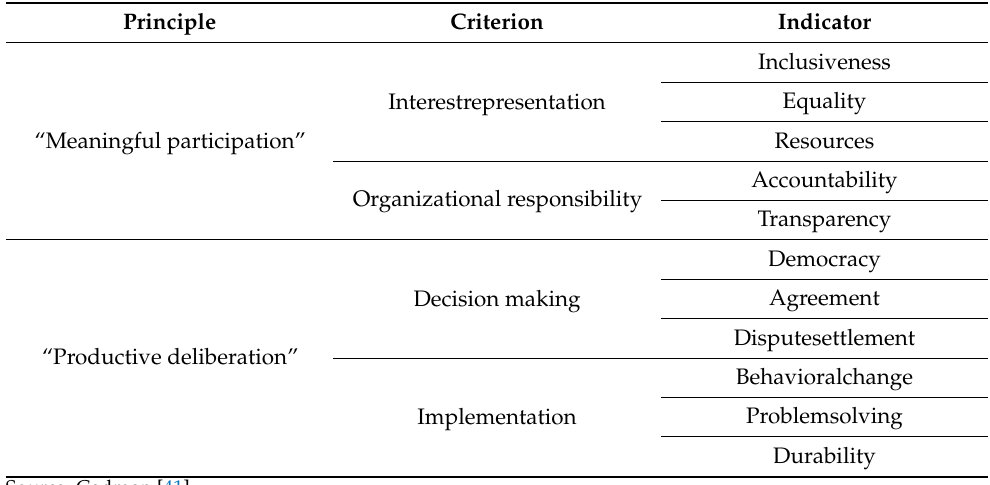
Table 1. Framework of Principle Criterion and Indicator (PC&I) for evaluating governance quality Cadman